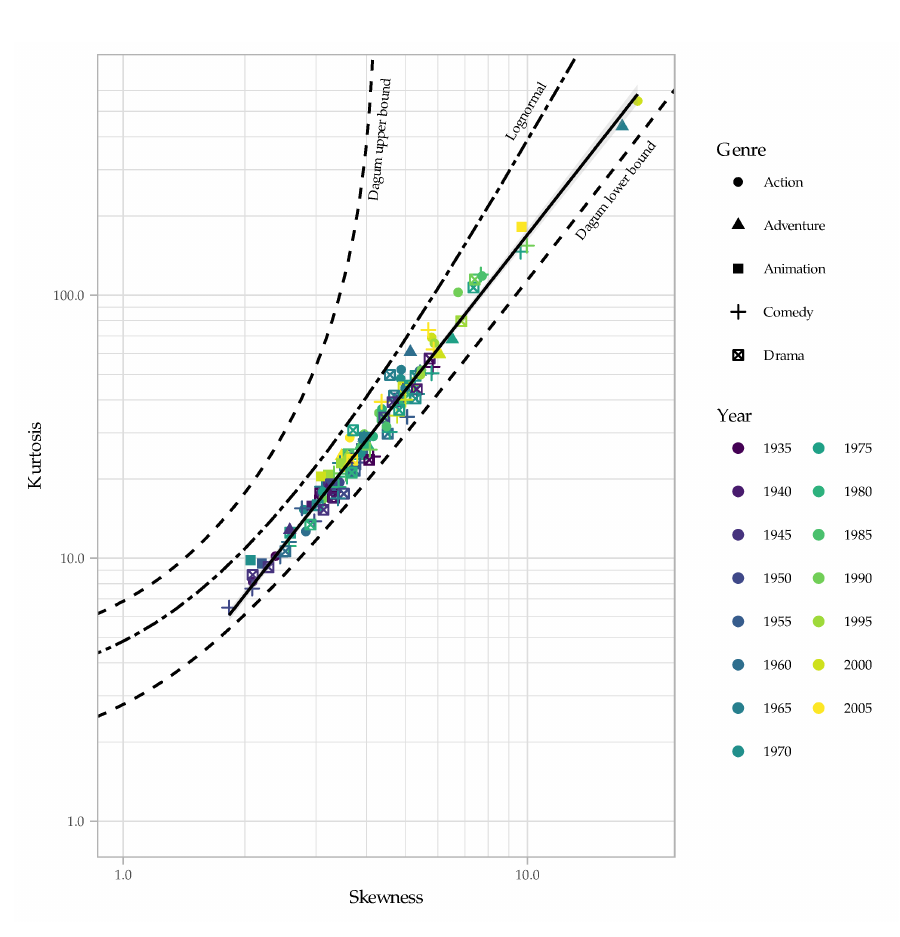
Figure 3 – Skewness ( S ) and kurtosis ( K ) values for shot length data of 134 Hollywood films released from 1935 to 2005 (Source: Cutting et al. (2010); http://www.cinemetrics.lv/database. php) . The Dagum distribution has two shape parameters and feasible combinations correspond when p = 1 and a > 4 to a region in the S - K plane, with the upper bound defined by S , K (cid:112) Dagum ( 1 − θ ) 1 + 2 /θ = 3 ( 3 θ 2 − θ + 2 )( 1 + 2 /θ ) < θ < 1. and the lower bound defined by the curve S = 2 θ + 3 and K ( θ + 3 )( θ + 4 ) for 0 With one shape parameter ( σ ), possible S - K values for the lognormal distribution are given by (cid:112) a curve defined by S = e 3 σ 2 + 3 e 2 σ 2 − 4, K = e 4 σ 2 + 2 e 3 σ 2 + 3 e 2 σ 2 − 3. The solid trendline is the power law K = 1.86 × S 1.96 fitted to the observed skewness and kurtosis values, with 95% confidence